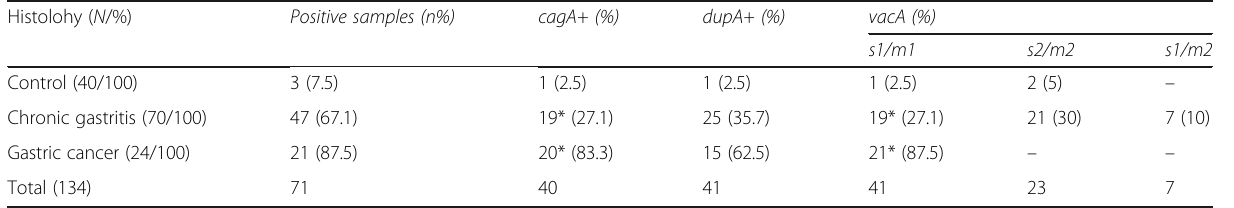
Table 1 Presence and characteristics of Helicobacter pylori in gastric biopsies Histolohy ( N